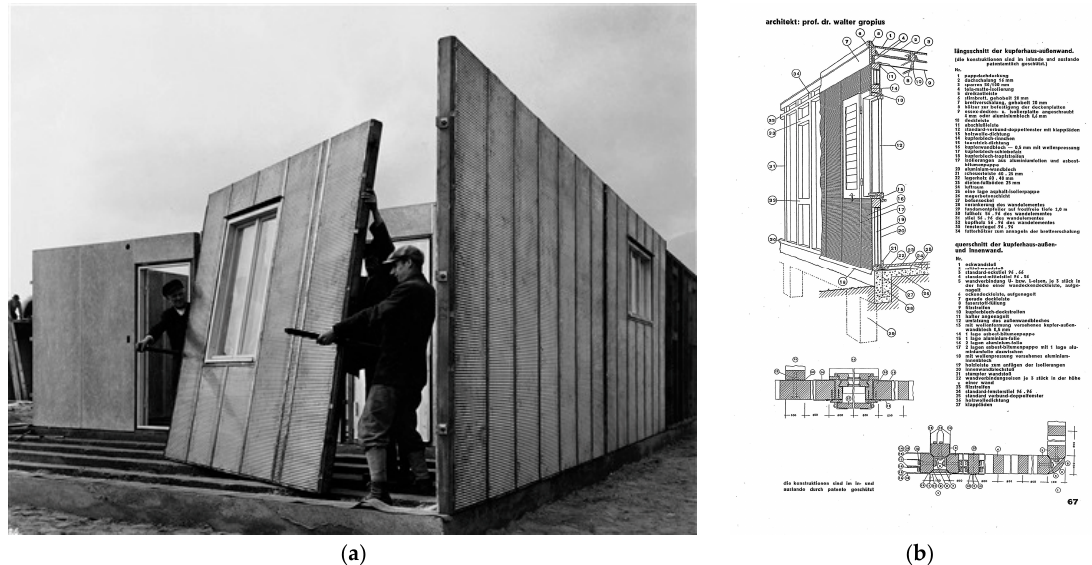
Figure 20. Walter Gropius: Förster-Krafft-System House exhibited at “Das wachsende Haus” (’The Growing House’) exhibition, Berlin, 1931–1932—Assembly process and façade construction detail. Images from (Wagner 1932, pp. 67–68).